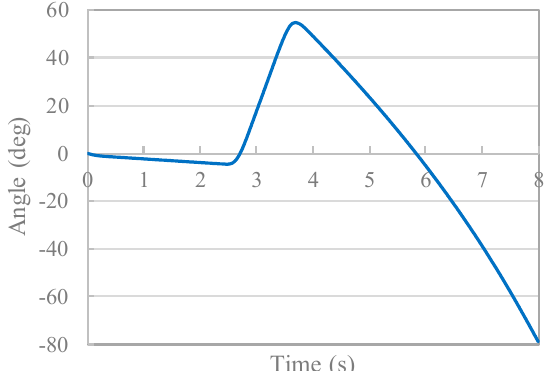
Figure 16. Time history of angle (without control).